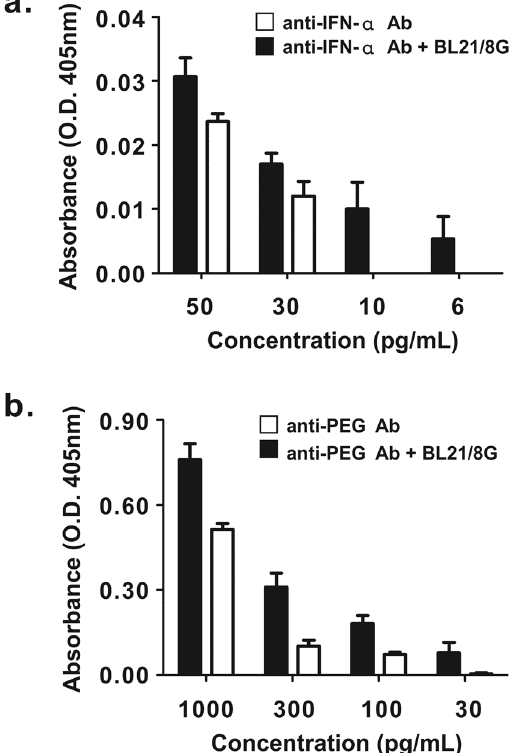
Figure 6. Detection of IFN- α and Pegasys by traditional sandwich ELISA or BL21/8G-based sandwich ELISA. ( a ) Serial diluted IFN- α samples were added into 96-well plates coated with anti-IFN- α capture antibody (MT1, IgM). Captured IFN- α molecules were detected by biotin-conjugated anti-IFN- α detection antibody (MT2, IgG) mixed with BL21/8G cells or not mixed with BL21/8G cells, and then color was developed using ABTS. ( b ) Serially diluted Pegasys samples were added into 96-well plates coated with anti-PEG capture antibody (AGP4, IgM). Captured Pegasys molecules were detected by biotin-conjugated anti-PEG detection antibody (3.3-biotin, IgG) mixed with BL21/8G cells or not mixed with BL21/8G cells, and color was developed using ABTS. Statistical analysis was performed by an independent t-test. Bar, SD.